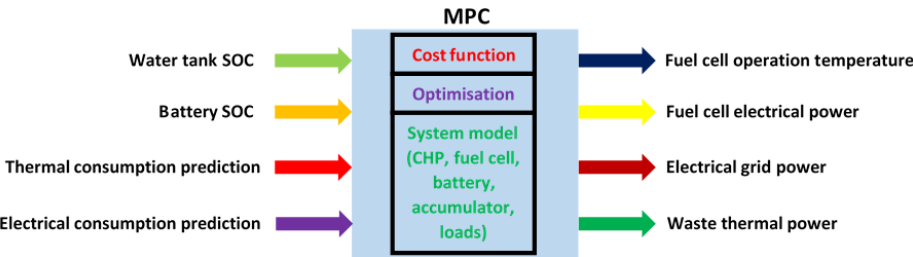
Figure 8. MPC scheme with variables and mathematical components.